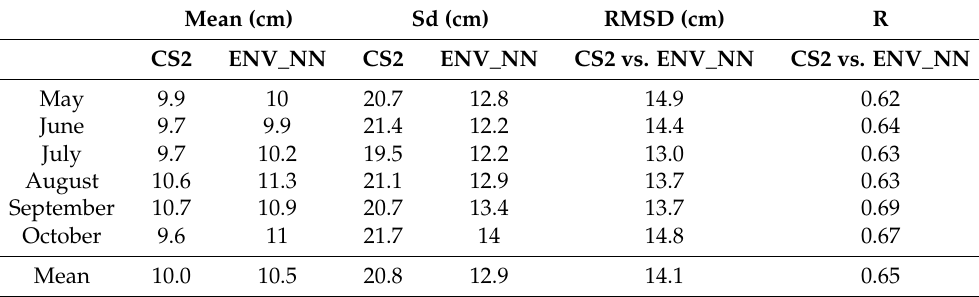
Table 1. Summary table of monthly sea ice radar freeboard statistics of Cryosat-2 and the calibrated version of Envisat during the May–October 2011 period. The mean, the standard deviation (Sd), the RMSD and the Pearson correlation coefficient R are calculated for sea ice concentration >